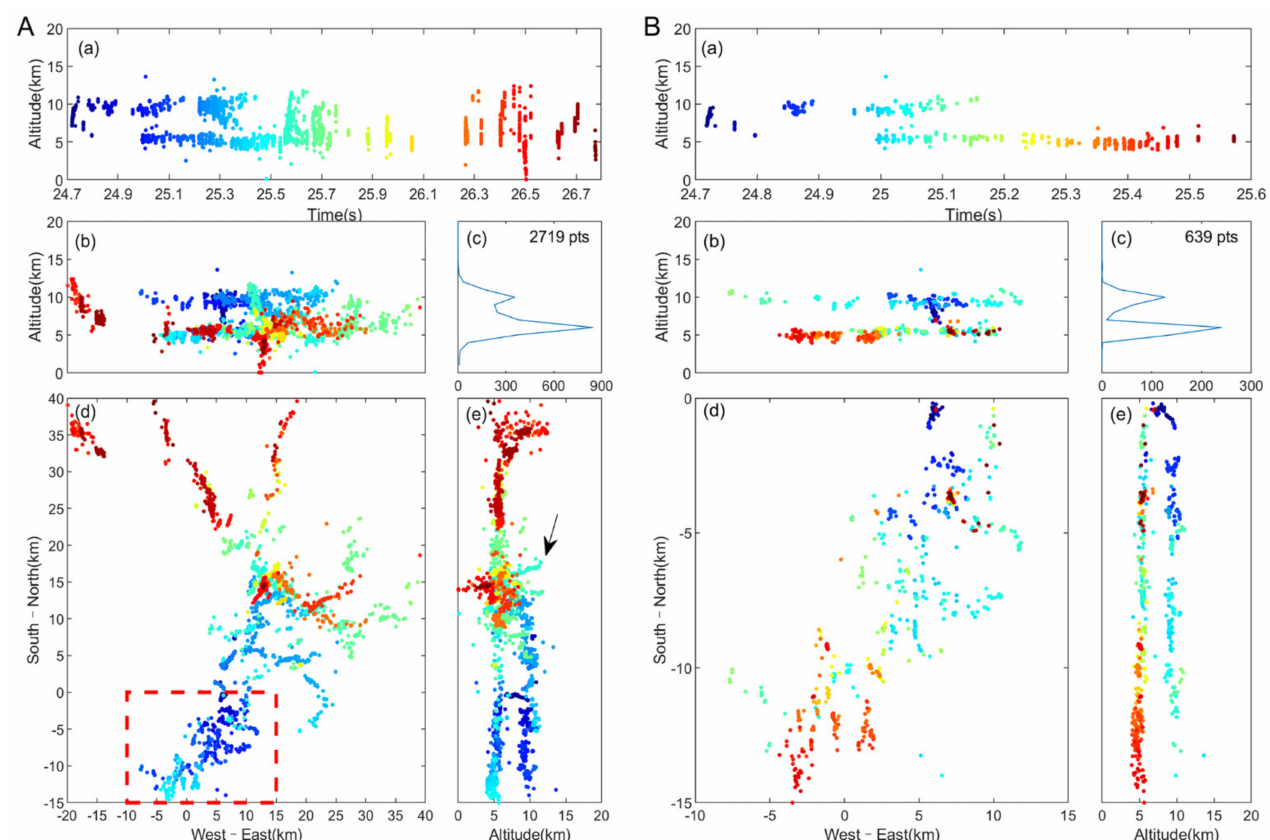
Figure 6. ( A ) Positioning results of a lightning process at 16:26 on 15 August 2015 by the new algorithm and ( B ) the partial development. In each subgraph, ( a ) height–time plots; ( b ) north–south vertical projection; ( c ) height distribution of radiation events; ( d ) plan view; and ( e ) east–west vertical projection of lightning radiation